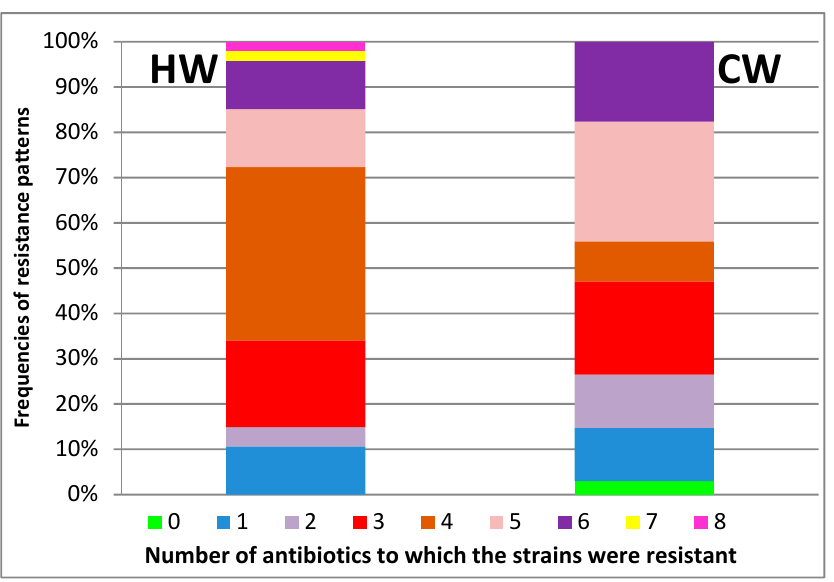
Figure 3. The proportion of multidrug-resistant E. coli (resistance to at least three antibiotics from three different classes—starting from no. 3) in hospital wastewater (HW) and community wastewater (CW) .